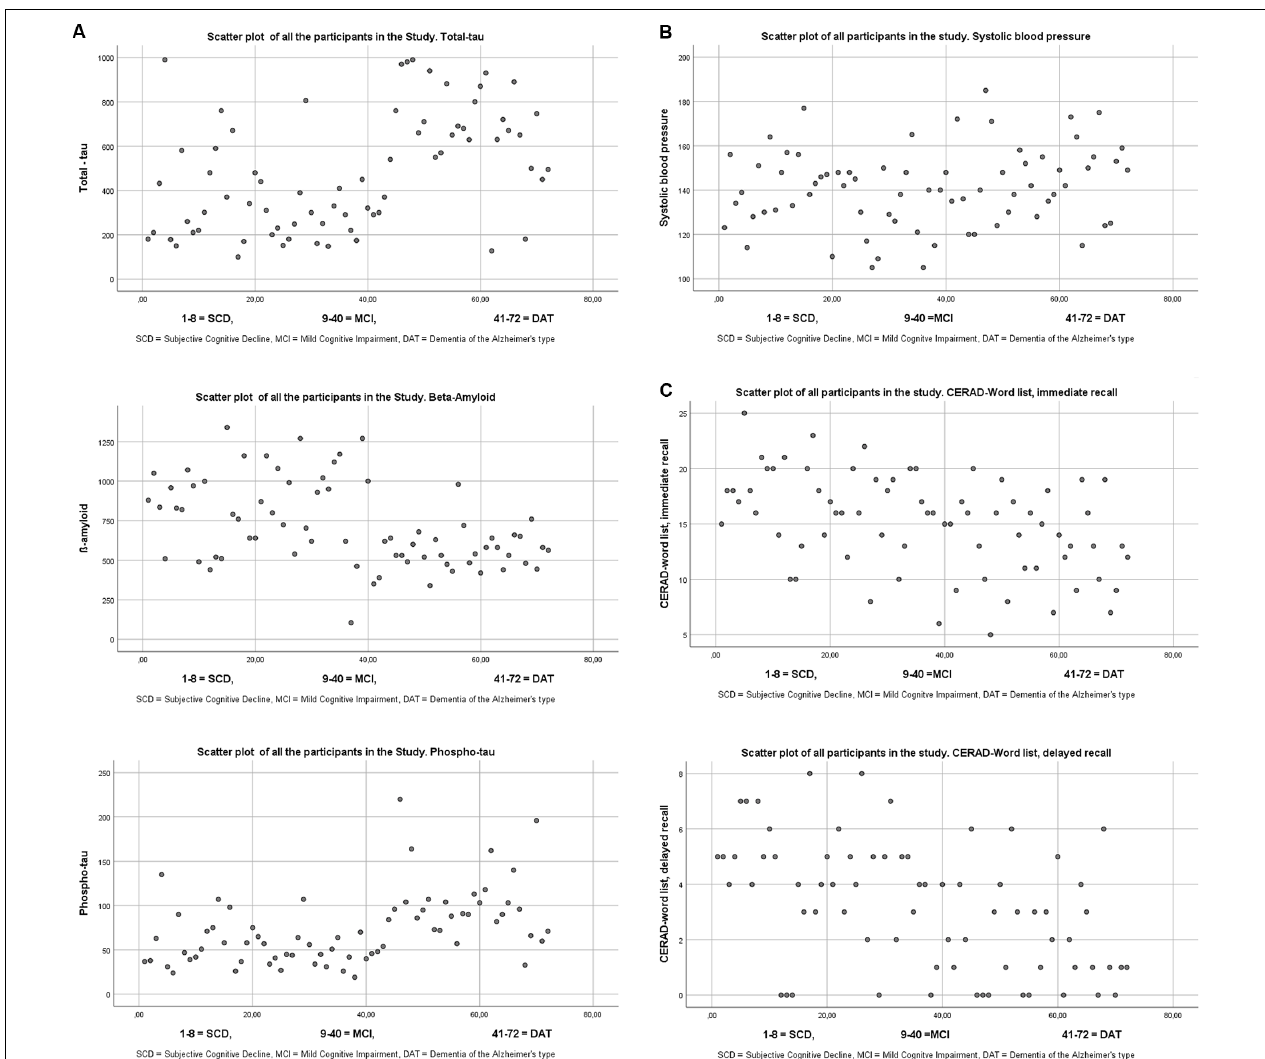
FIGURE 1 | (A) Scatterplots of the three different biomarkers from cerebro spinal fluid. The cutoffs for the three biomarkers according to the laboratory (See Knapskog et al., 2017) were for total tau < 300 for patients under 50 years, < 450 for patients ages 50–69, and < 500 for those 70 years and older. It is only total-tau that has age-specified norms. Cut off for β -Amyloid > 550, and for phospho tau < 80. (B) Scatter plot of Systolic blood pressure. (C) Scatter plot of the